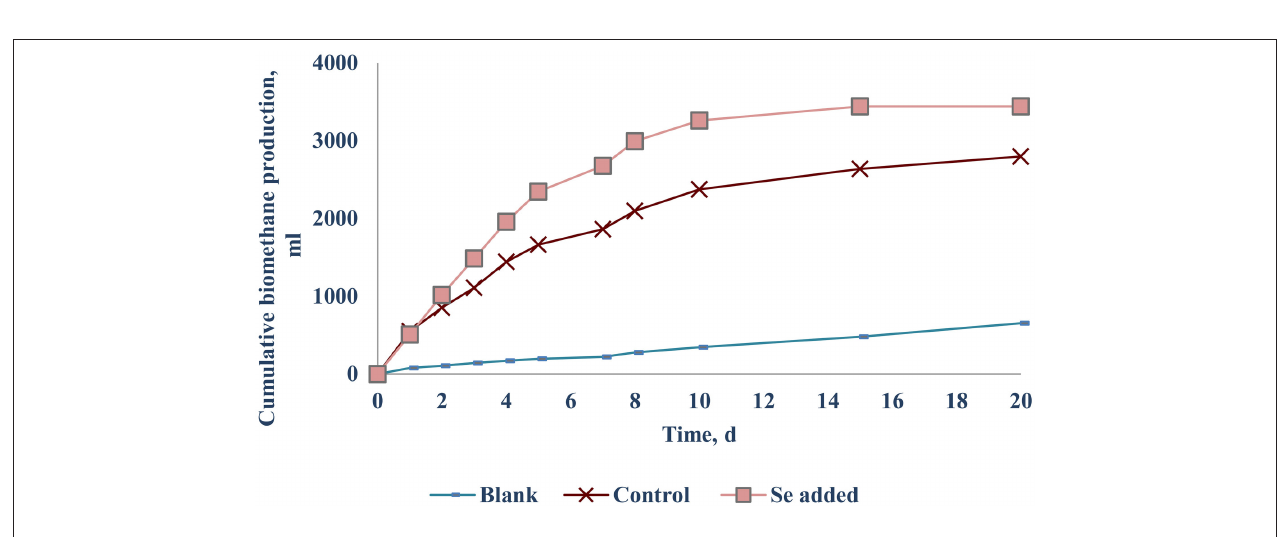
FIGURE 6 | Effect of Se (VI) addition on